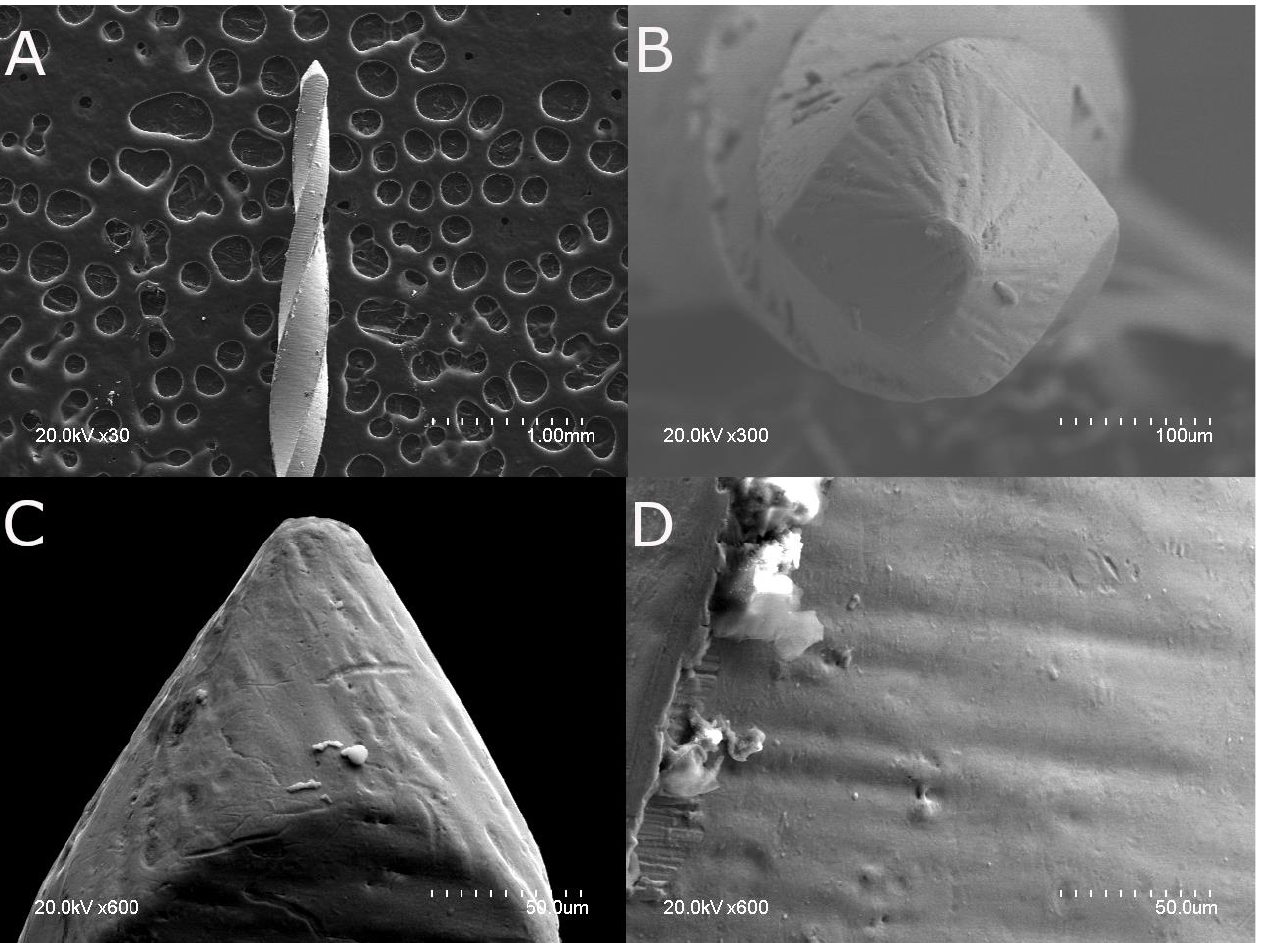
Figure 1. NiTi alloy endodontic rotary file SEM analysis at ( A ) 30×, ( B ) 300×, and ( C , D ) 600× magnification.